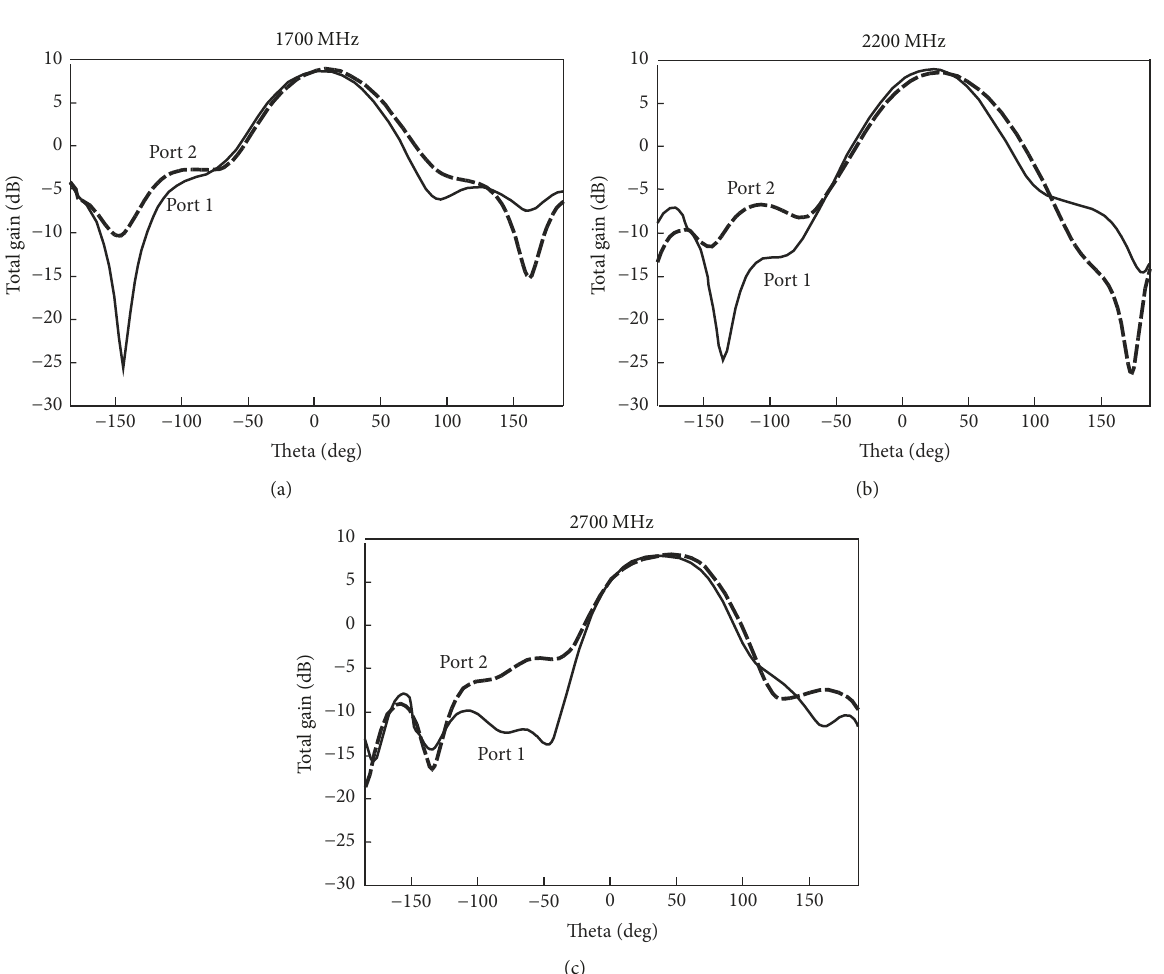
Figure 6: Measured radiation patterns in 𝑌𝑍 -cut at (a) 1700 MHz, (b) 2200 MHz, and (c) 2700 MHz. The 3 dB beamwidths are 70 ∘ , 68 ∘ , and 75 ∘ ,